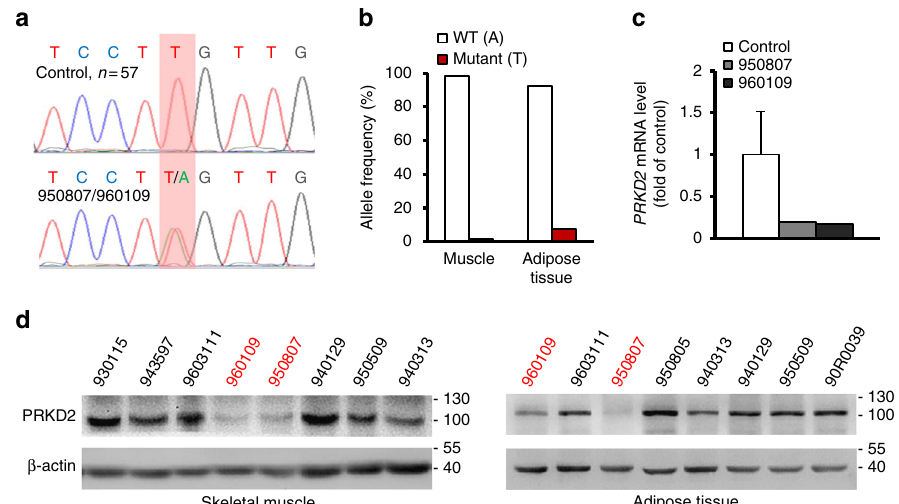
Fig. 3 PRKD2 K410X variation is shared by two hyperinsulinemic monkeys. a Sanger sequencing indicating one heterozygous nonsense variation in PRKD2 (K410X) exclusive to the two cases (950807, 960109). b As for the PRKD2 nonsense variation, the allele frequencies of the two alleles (WT, Mutant) were shown, according to the RNA-seq data in muscle and adipose tissue from a PRKD2 mutant monkey (950807). c Real-time PCR quanti fi cations of the PRKD2 expression in skeletal muscle of WT and the PRKD2 mutant monkeys. d Western blots of PRKD 2 protein expression in skeletal muscle (left) and adipose tissues (right) from control (black) and hyperinsulinemic (red)